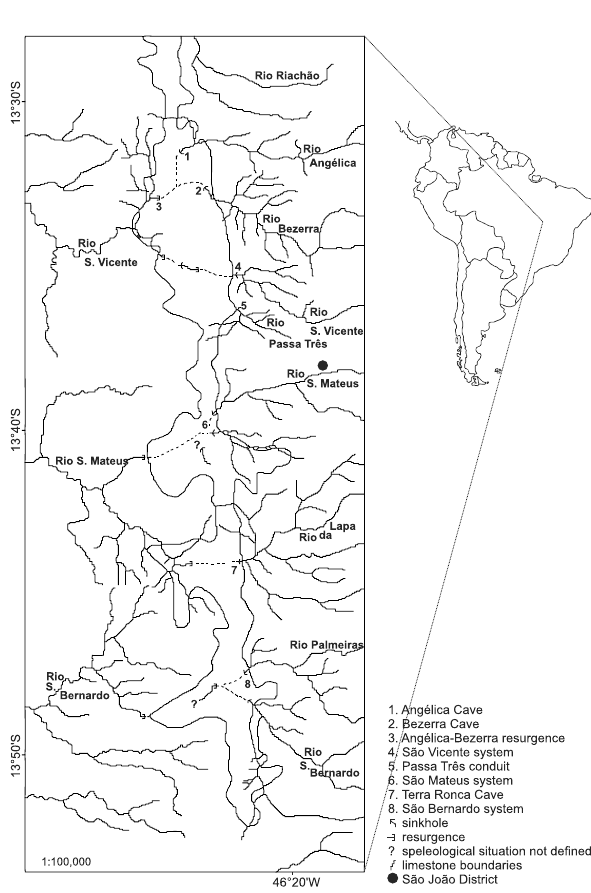
Figure 20. Map of distribution of Paecilama batman sp. nov. in the state of Goiás,